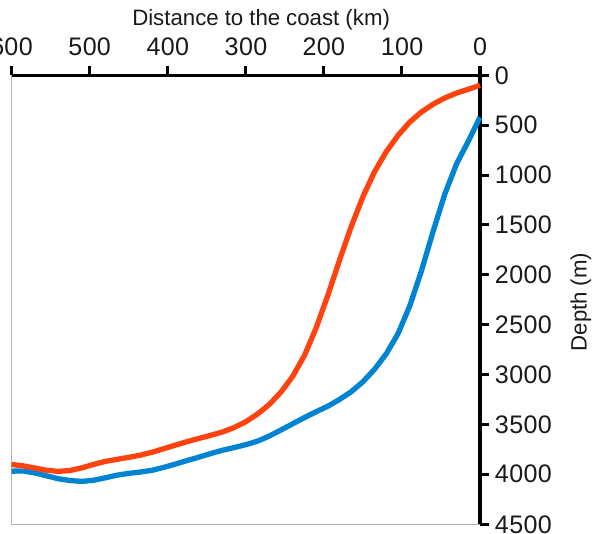
Fig. 11. Alongshore averaged bottom topography depth as a func- tion of distance to the coast in the the Canary CS 15km simulation with unaltered topography (orange) and the 15km narrowed-shelf simulation (blue).